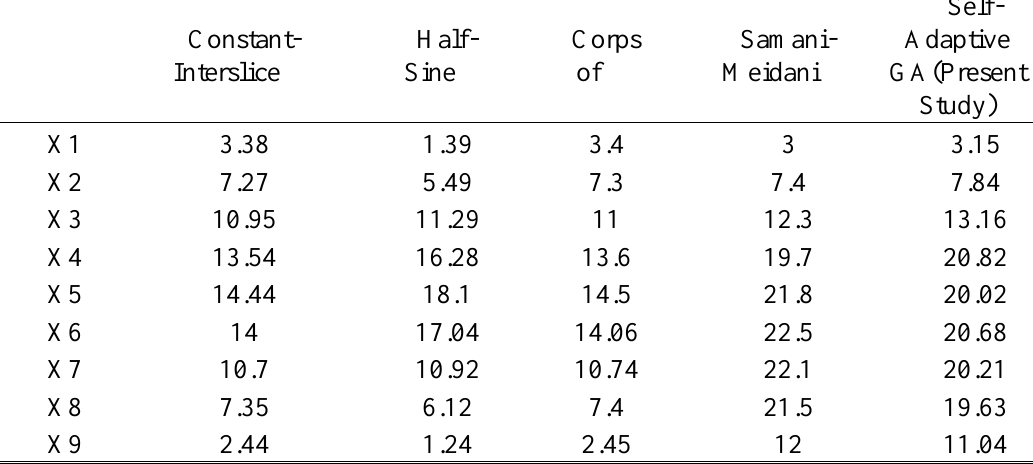
Table 5. Inter-slice shear force calculated by different